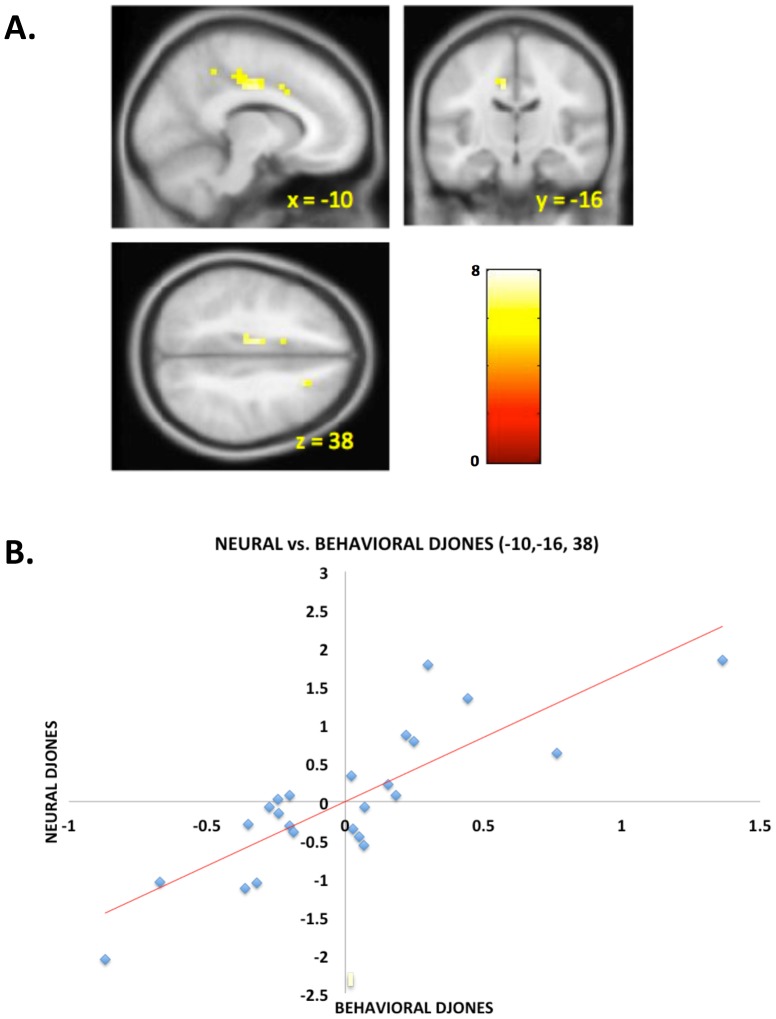
Neural interpersonal error sensitivity covaries across subjects with behavioral influence of interpersonal error in middle cingulate.
A. Across subject regression of the beta maps from the neural DJONES regressor against the behavioral DJONES coefficients revealed a significant (p<.05, whole – brain FWE corrected) linear relationship in middle cingulate. B. Plot of individual values of neural DJONES from peak voxel in middle cingulate (MNI [−10,−16,38]) versus individual behavioral DJONES coefficients (mean adjusted).